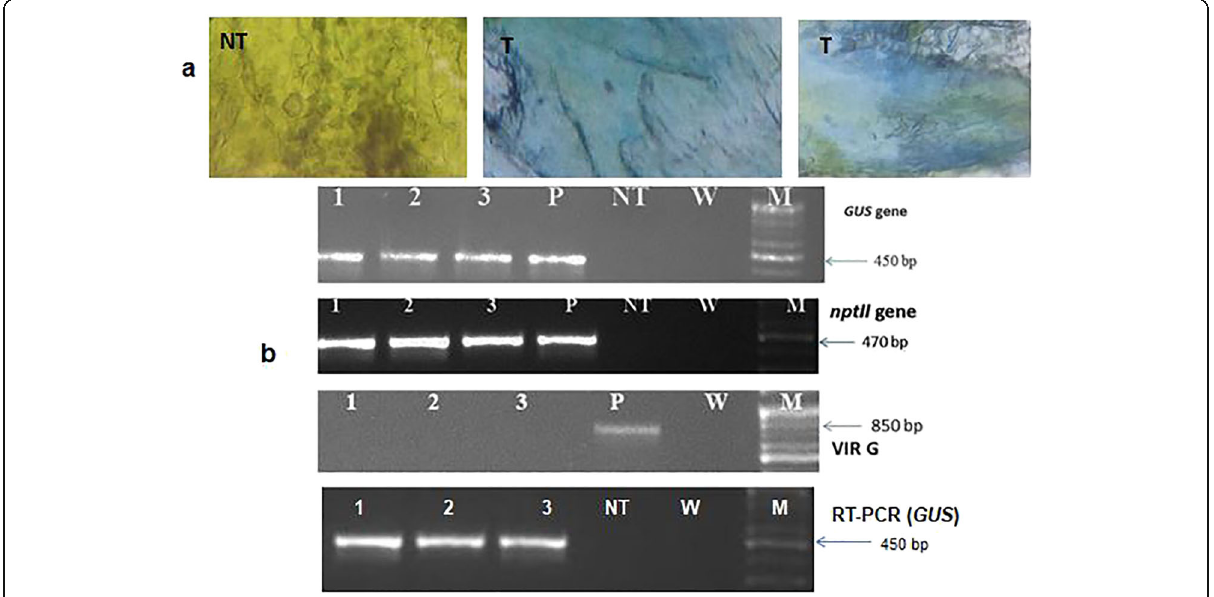
Fig. 3 a Histochemical GUS assay using Trachyspermum ammi leaves, T: Putative transformed plant, NT: non-transformed plant (control); b Results related to PCR analysis of GUS , nptII , VIR G , and RT-PCR analysis. 1 – 3 putative transgenic plant, P: positive control (plasmid), NT: non-transformed herb, W: negative control, M: 100 bp DNA